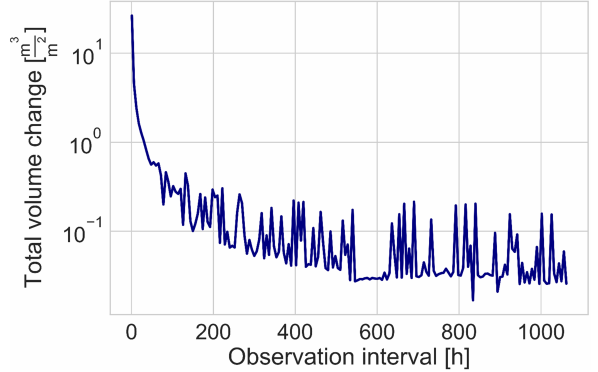
Figure 8. Relation of observation interval to the volume budget observed in the time series dataset over a period of six